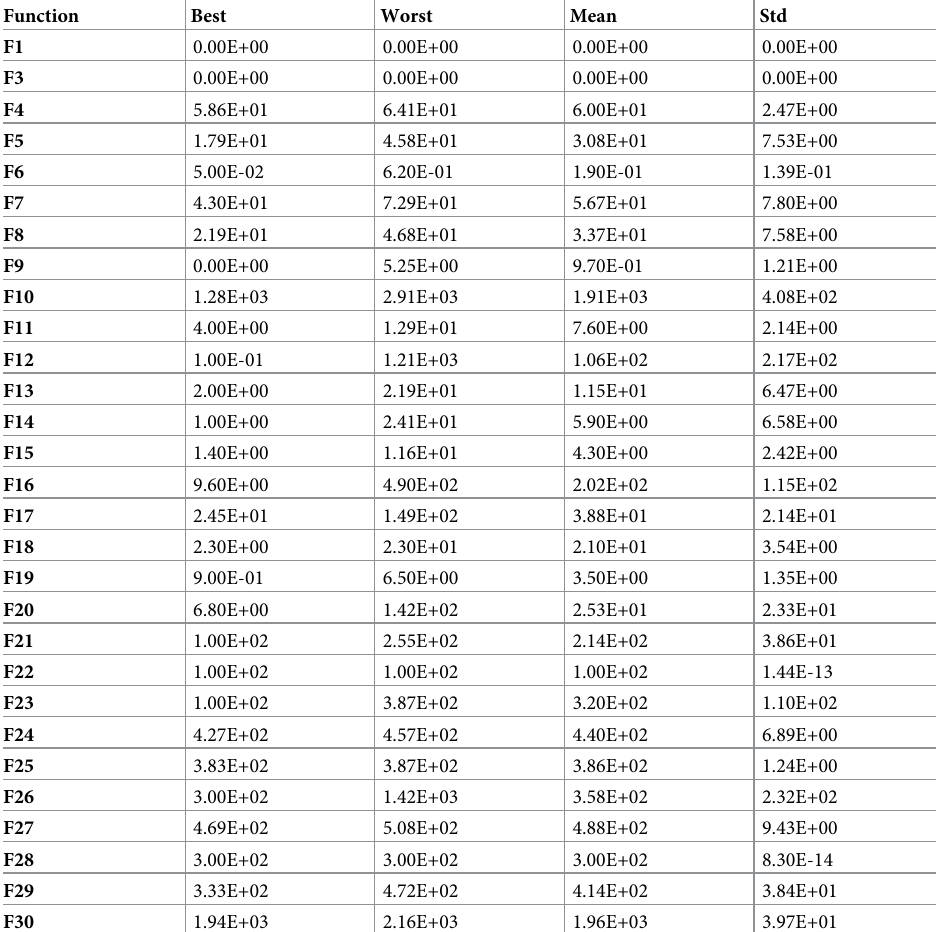
Table 7. Results for ADMO in 30